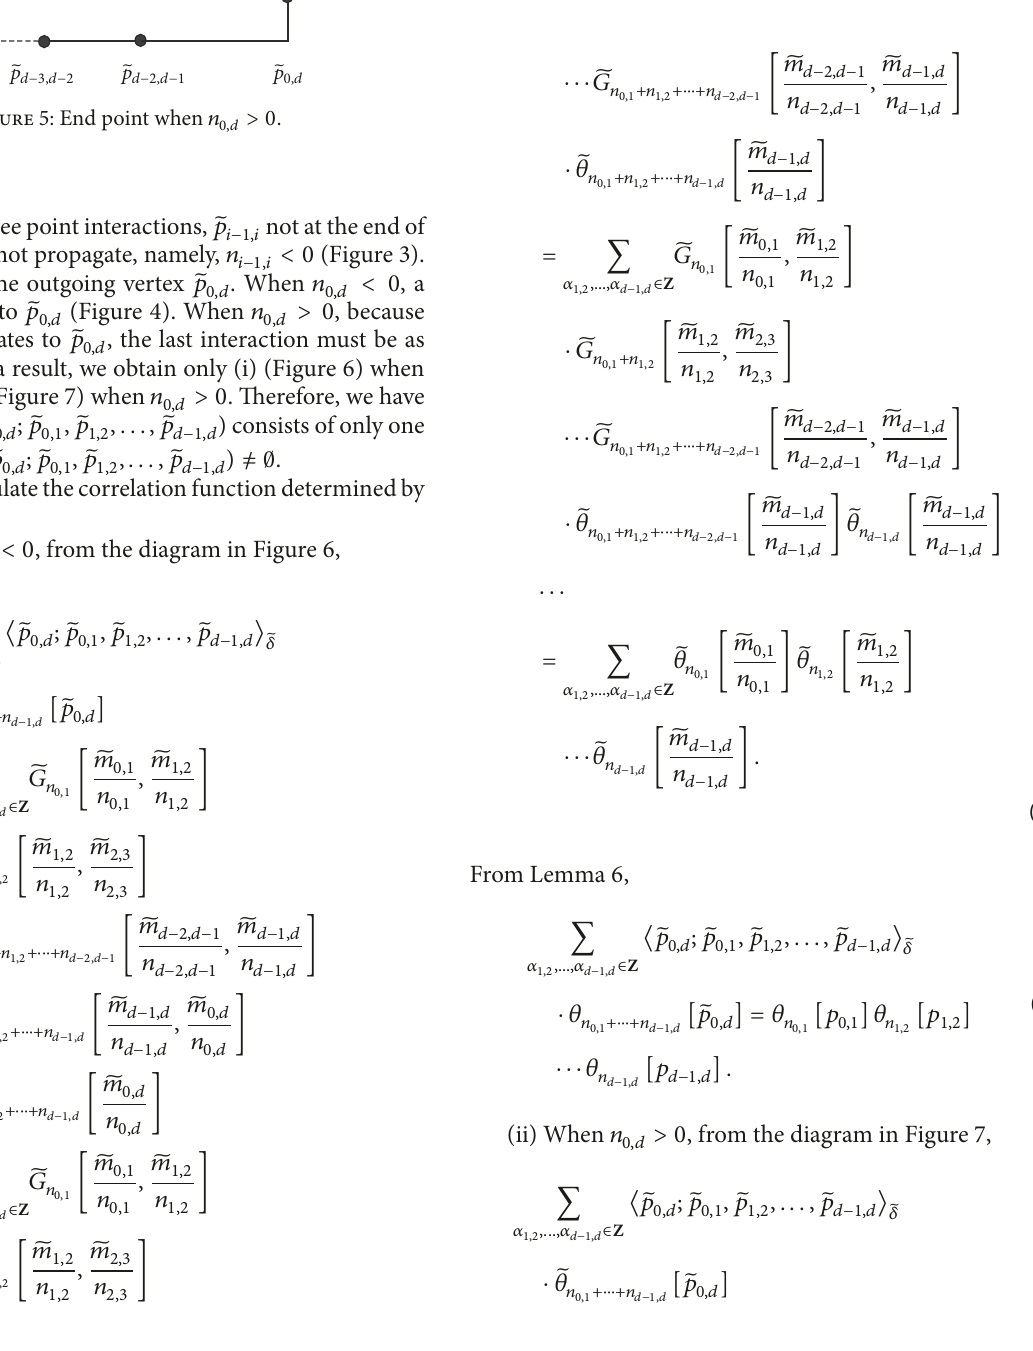
Figure 7: When 𝑛 0,𝑑 > 0